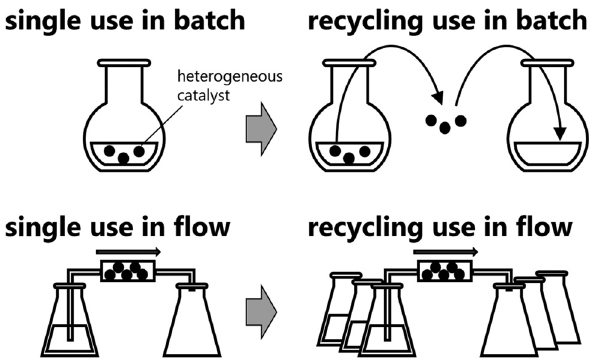
Figure 1: Schematic for recycling a heterogeneous catalyst in batch and fl